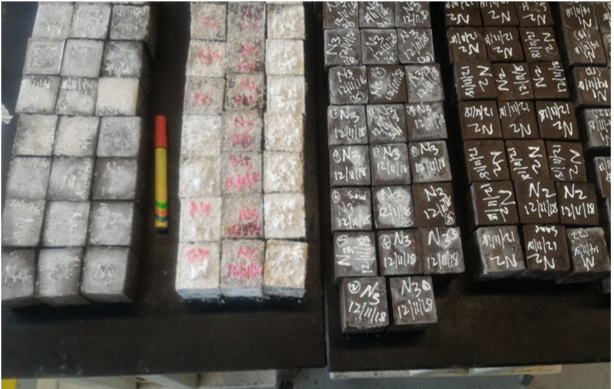
Figure 7. Extent of efflorescence formation of OPAAP.